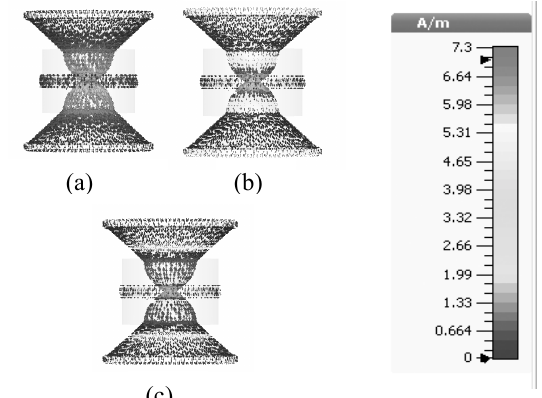
Figure 5: Simulated surface current distribution of Canonical Sleeve Antenna (CSA) at (a) 0.5 GHz (b) 2 GHz (c) 3.6 GHz